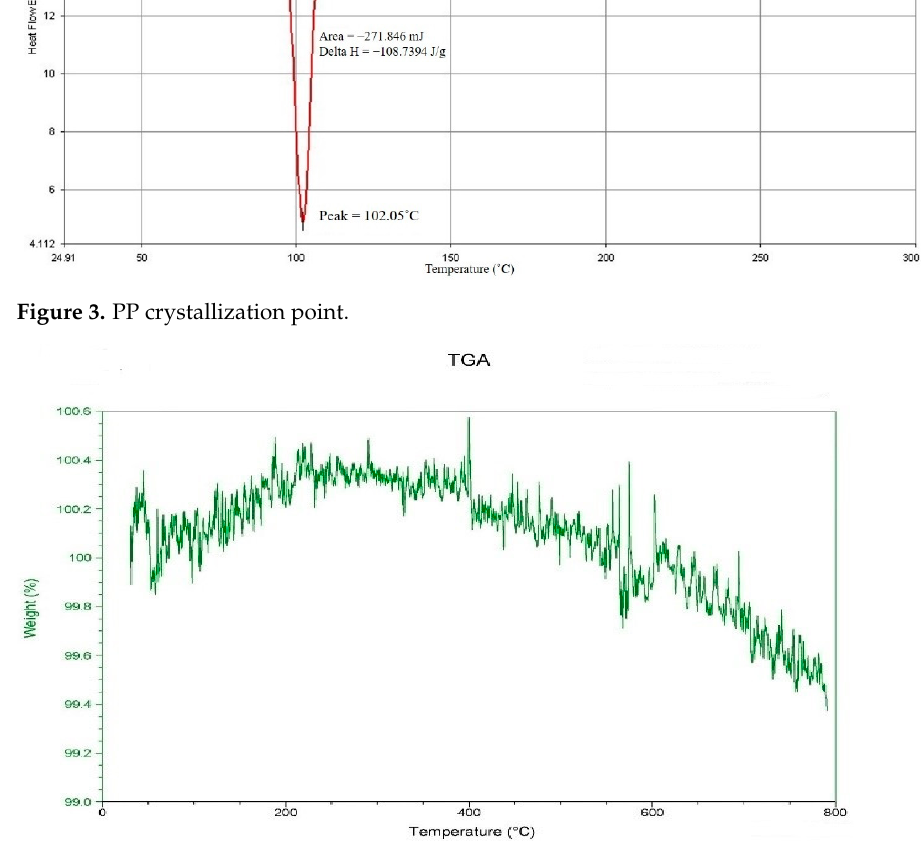
Figure 4. Thermo gravimetric loss of SiO 2 .